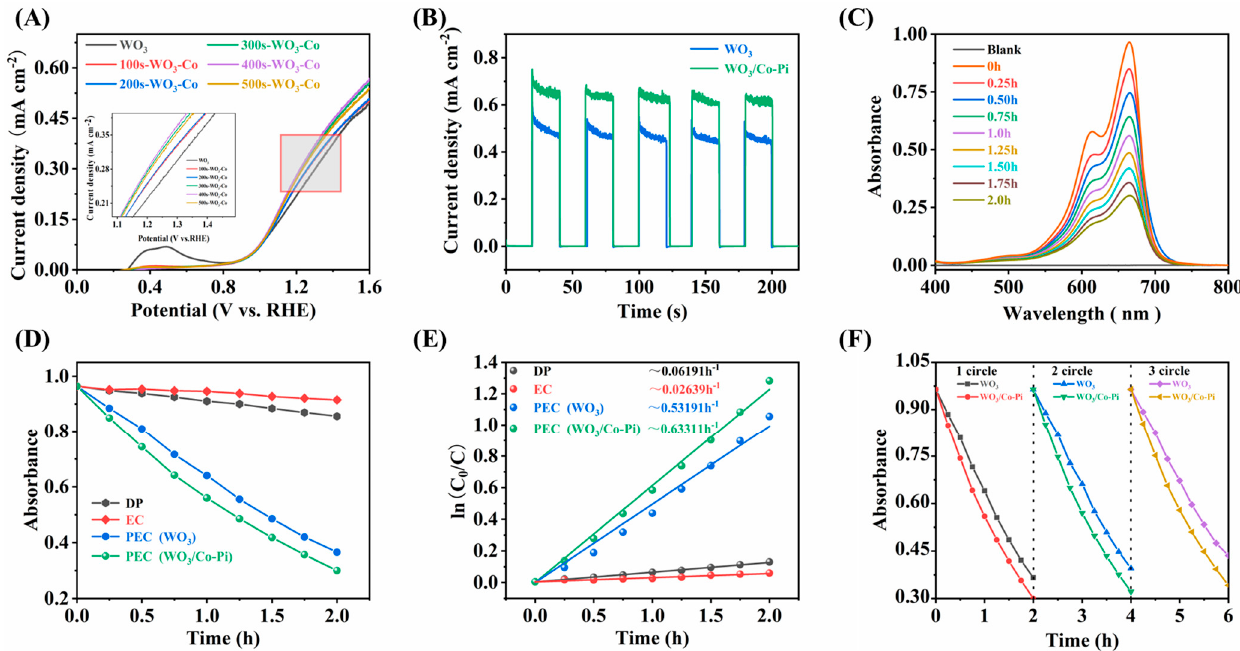
Figure 3. ( A ) LSV curves of WO 3 films before and after Co-Pi modification under 100 mW·cm − 2 light; ( B ) photoresponse current profiles of WO 3 films before and after Co-Pi modification; ( C ) UV absorption spectra of MB degraded by Co-Pi/WO 3 films under AM1.5 illuminations at 1 V applied voltage; ( D ) DP, EC and PEC degradation of MB under AM1.5 illuminations at 1 V applied bias voltage before and after Co-Pi modification of WO 3 films; ( E ) corresponding kinetic curves before and after Co-Pi modification of WO 3 films; ( F ) variation of the performance of MB degradation under PEC conditions with three cycles.